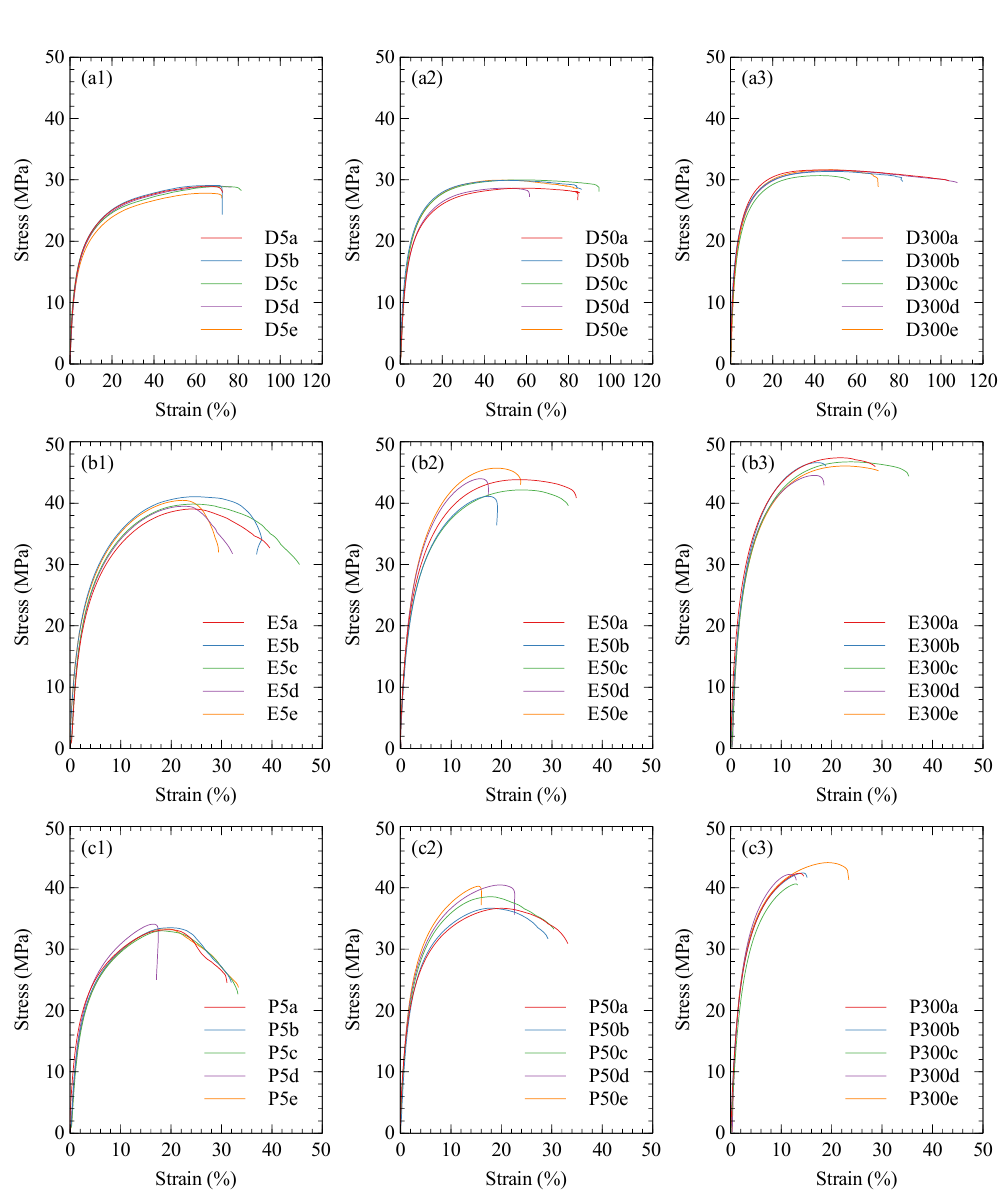
Figure 3. Onyx tensile stress–strain curves. The infill geometry is denoted by ( a ) default, ( b ) on-edge, and ( c ) parallel. Tensile speed denoted by ( 1 ) 5 mm/min, ( 2 ) 50 mm/min, and ( 3 ) 300